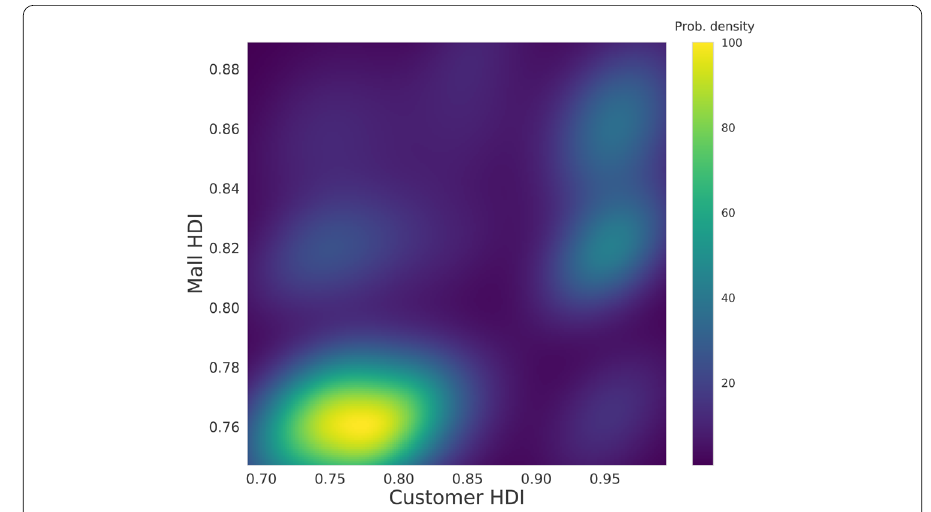
Figure 13 Bidimensional Kernel Density Estimation of the distribution of (customer HDI, mall HDI) where the sample space is the set of all mall visits during the